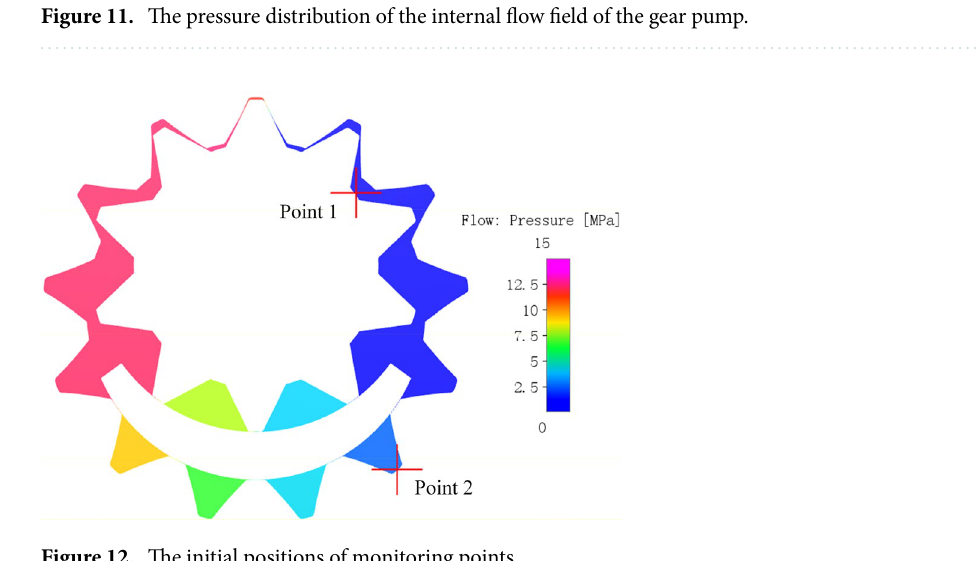
Figure 12. The initial positions of monitoring